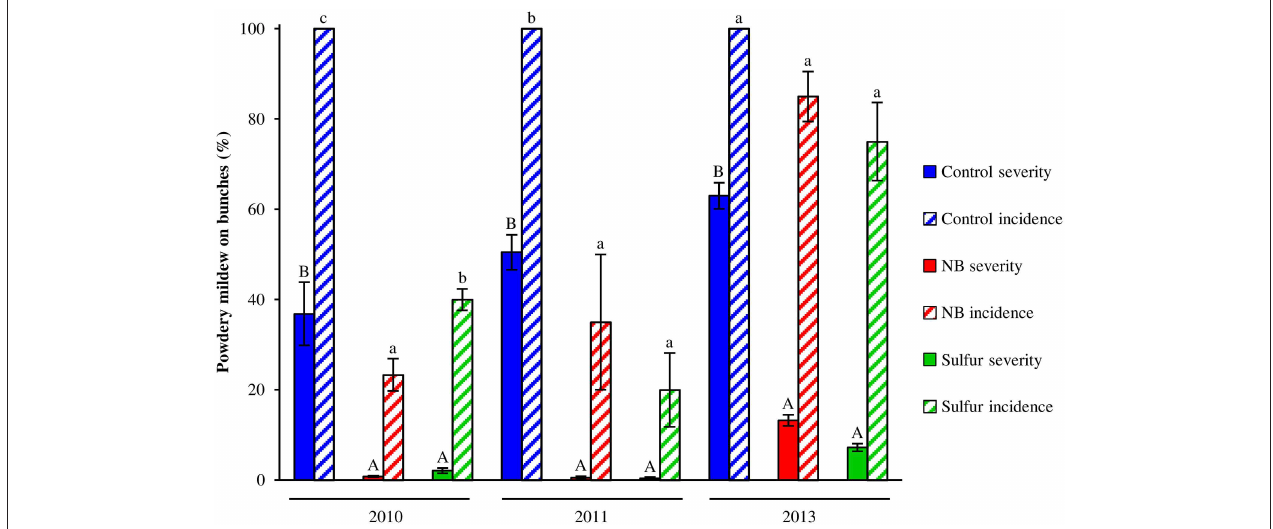
FIGURE 2 | Effect of nutrient broth against powdery mildew on grape bunches under field conditions. Powdery mildew severity and incidence was assessed on bunches of grapevines treated with water (Control), nutrient broth (NB) or sulfur (Sulfur), as standard fungicide, under field conditions in three different seasons (2010, 2011, and 2013). Treatments were applied weekly from the beginning of May to the middle of August. Disease severity and incidence were assessed weekly as percentage of bunch area covered by white sporulation and percentage of bunches showing symptoms by scoring 20 bunches per replicate, respectively. The mean severity and incidence scores and the standard errors of three replicates (eight plants each) are presented for each treatment. For each year, uppercase and lowercase letters indicate significant differences among treatments according to Tukey’s HSD test ( α = 0.05 ) of disease severity and incidence, respectively.